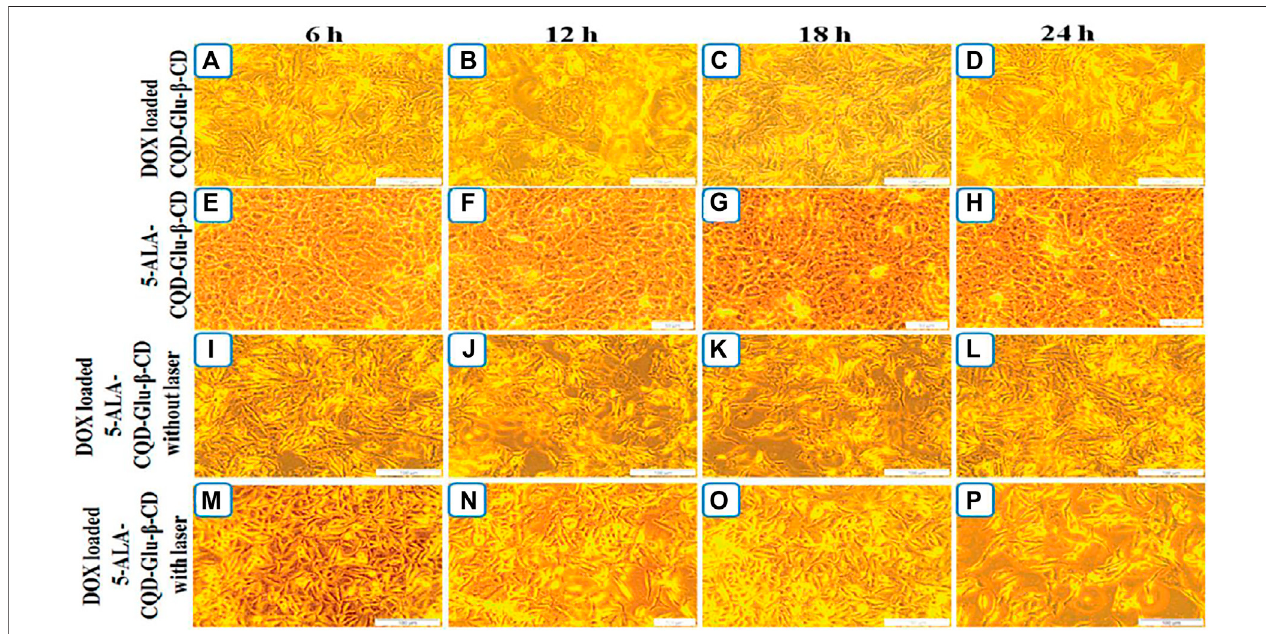
FIGURE6| Breastcancer(MCF-7)cellstreatedwithDOX/CQD-Glu-b-CDafter[(a)6h,(b)12h,(c)18h,(d)24h],5-ALA-CQD-Glu-b-CDafter[(e)6h,(f)12h,(g)18 h,(h)24h],DOX/5-ALA-CQD-Glu-b-CDnanocarrierwithirradiation[(i)6h,(j)12h,(k)18h,(l)24h]andDOX/5-ALA-CQD-Glu-b-CDnanocarrierwithoutirradiation[(m)6 h, (n) 12 h, (o)18 h, (p) 24 h] and IC50 concentration of 60lg/mL underwent in vitro morphology. Reproduced froLi et al. (2020) under creative commons CC BY license. Copyright © 2020 The